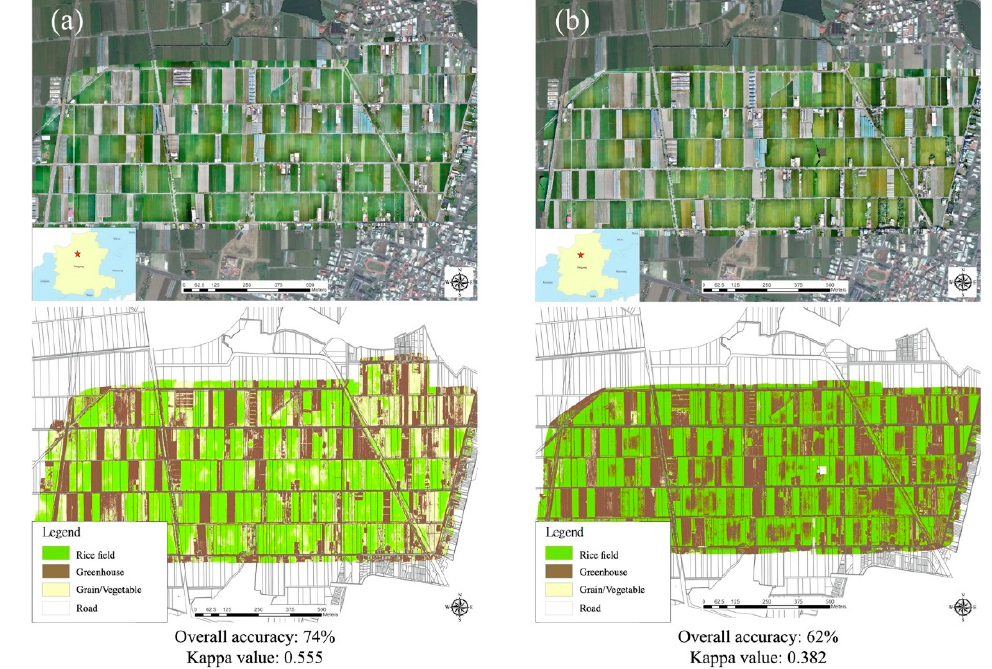
Figure 5. Interpretation accuracy at the Xingang sampling site. The orthophoto captured on ( a ) 13 September 2018; ( b ) 26 October 2018. Table 4. Accuracy assessment results for three image composites at the Xingang sampling site.